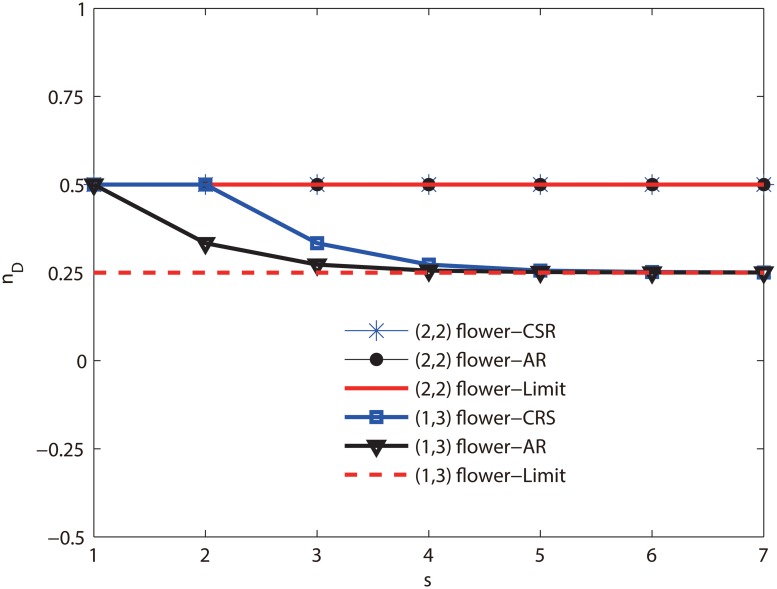
Controllability measure n
D is a function of iteration step s for the (2, 2) flower network and the (1, 3)-flower network, respectively.CSR denotes the results by computer simulation. AR denotes the results predicted by Eqs (12) and (17) for the two networks. Limit denotes the thermodynamic limit predicted by Eqs (13) and (18). The two networks are iterated to step 7. For the (2, 2)-flower network, three curves of CRS, AR and Limit are coincide. For the (1, 3) flower network, three curves of CRS, AR and Limit are almost entirely the same at s ≥ 4.